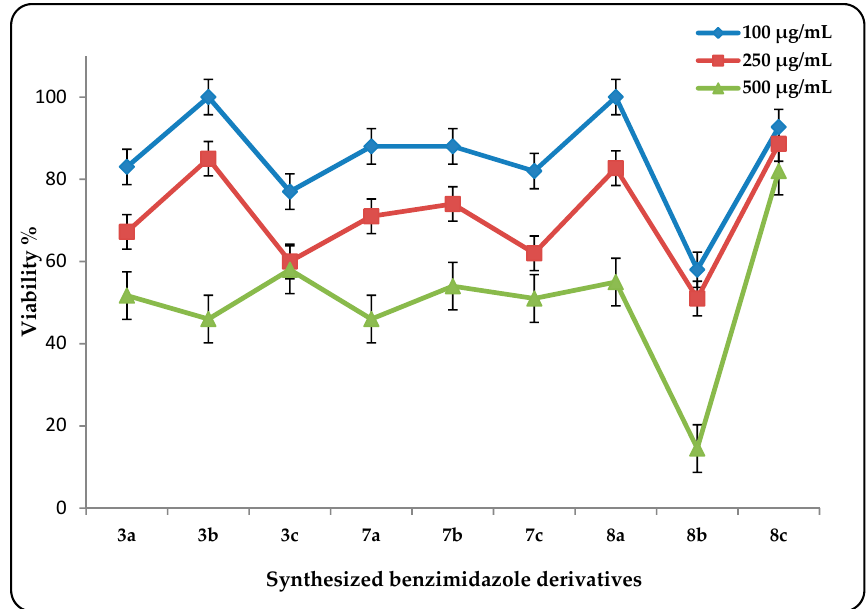
Figure 4. The viability % of human liver cancer (HepG2) cell line treated with the synthesized benzimidazoles at 100 µg/mL, 250 µg/mL, and 500 µg/mL based on three independent experiments.